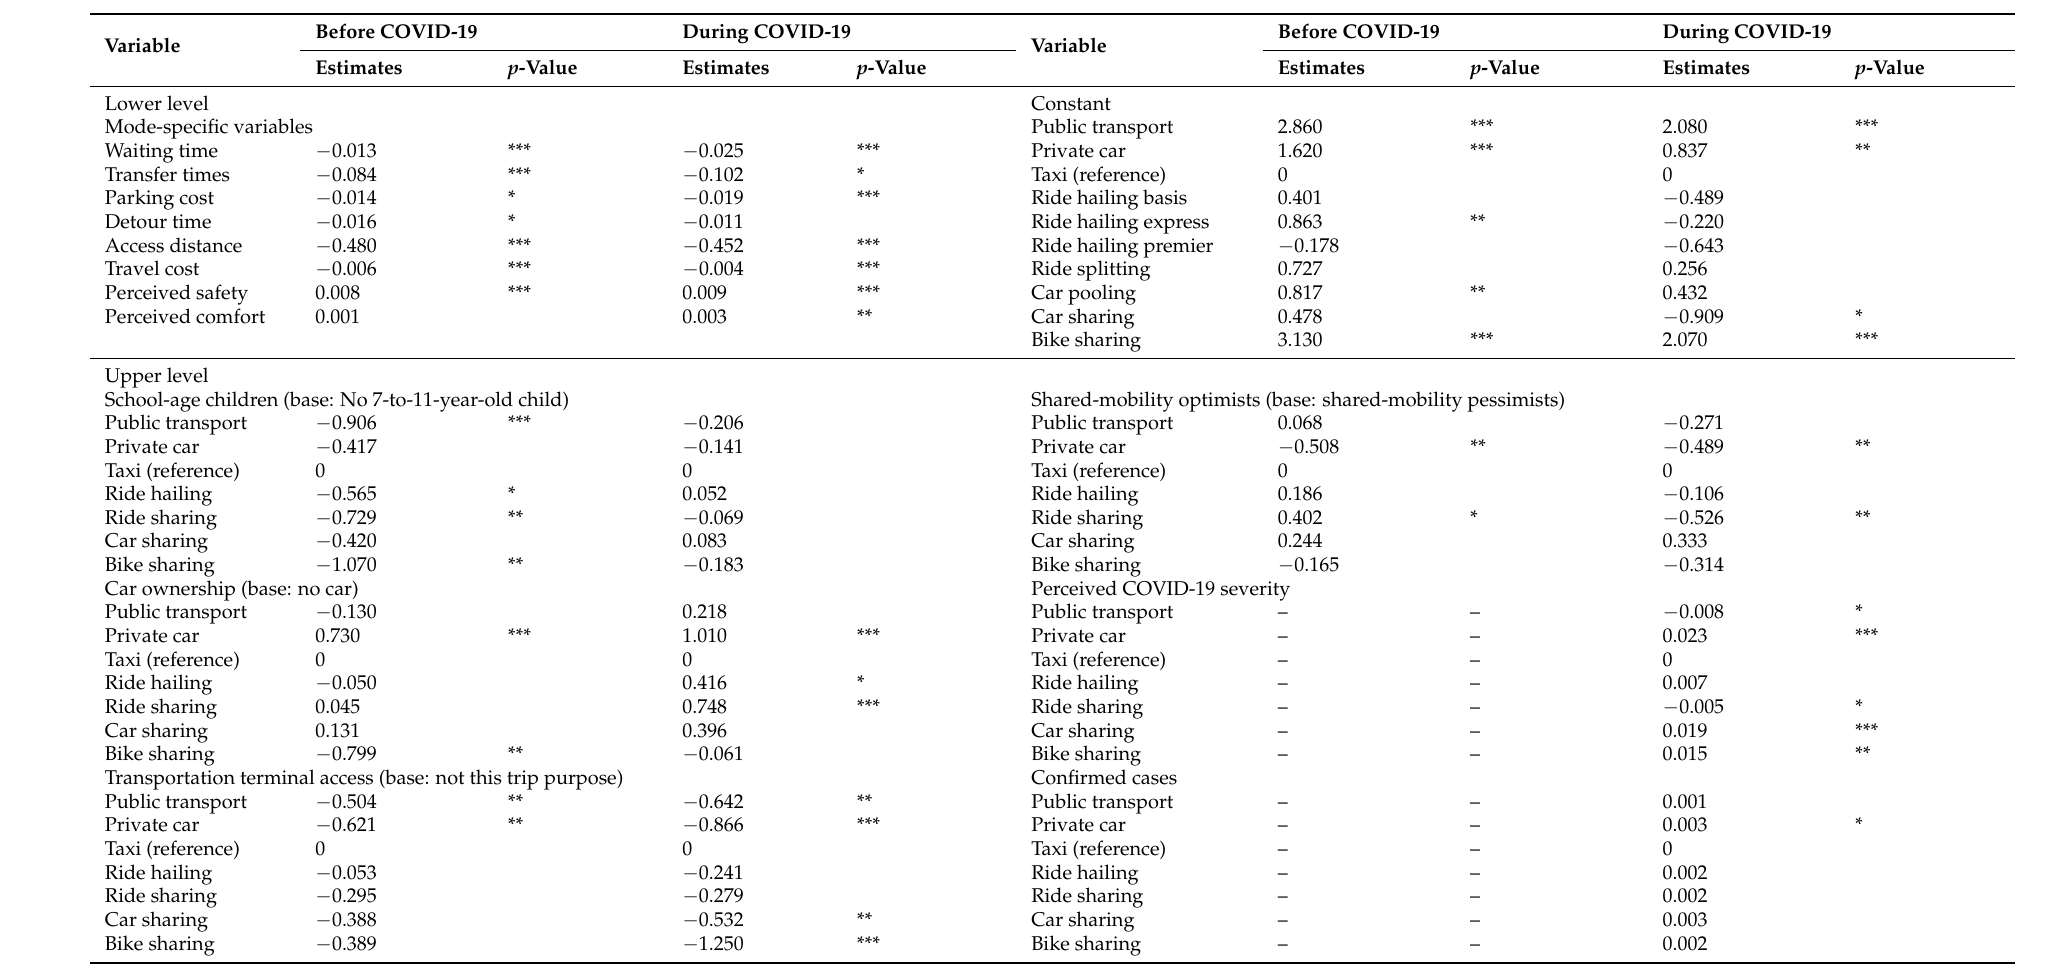
Table 5. Estimated results of NL